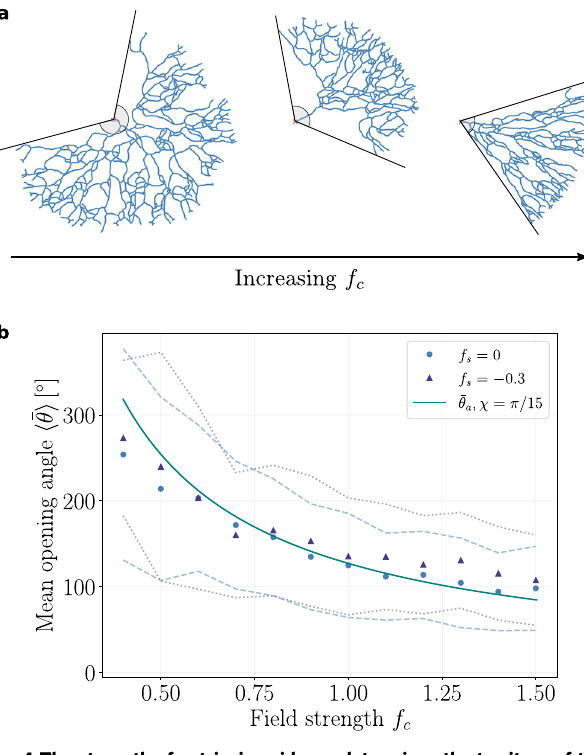
Fig. 4 The strength of extrinsic guidance determines the territory of the branched structures in simulations, with minimal in fl uence from local self-avoidance. a Representative simulation snapshots highlighting the changes in the opening angle (cid:1) θ (a proxy for territory size in a radial geometry, gray circular segments) with increasing external fi eld strength f c . b Mean opening angles h (cid:1) θ i of branched networks decrease monotonically with increasing external fi eld strength f c , and have similar values for networks with zero ( f s = 0, circular markers) or with strong ( f s = − 0.3, triangular markers) self-avoidance. Errors of the averages are determined by the standard deviations and highlighted by the dashed and dotted lines for f s = 0 and f s = − 0.3, respectively. The monotonic decrease of h (cid:1) θ i obtained from simulations is well-described by the analytical approximation (cid:1) θ fi t parameter χ = π a (solid line), see Eq. (3), with the